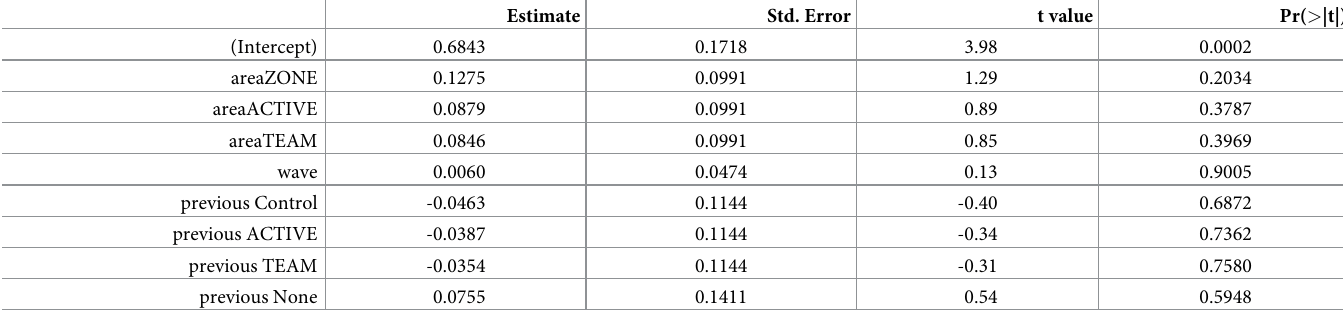
Table 14. GLM results for environment.